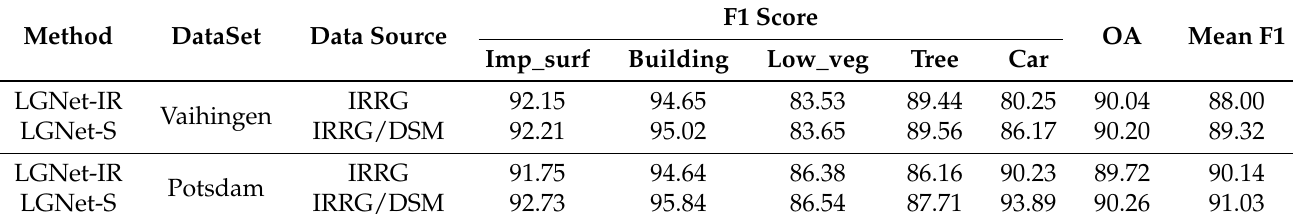
Table 1. The effect of different source images on the ISPRS Vaihingen and Potsdam datasets.